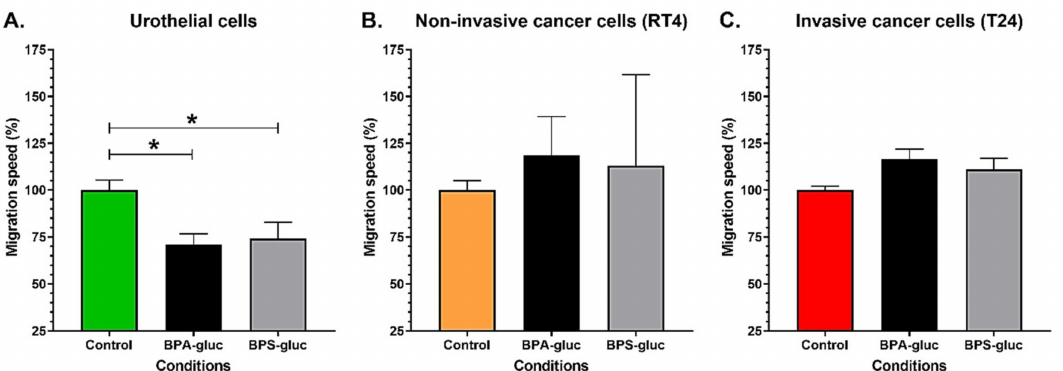
Figure 4. Chronic exposure to physiological concentrations of glucuronidated BPA or BPS decreases the migration speed of normal urothelial cells. The migration speed of ( A ) normal urothelial cells (UCs), ( B ) RT4 non-invasive bladder cancer cells, and ( C ) T24 invasive bladder cancer cells was evaluated by time-lapse microscopy with or without chronic exposure to physiological concentrations of BPA-gluc or BPS-gluc. Data are presented as the mean ± SEM and displayed as percentages of controls (i.e., untreated condition) (n = 2, N = 3). The 100% migration value of UCs’ control represents a mean of 12.1 cm 2 /h, for RT4 1.7 cm 2 /h, and for T24 4.8 cm 2 /h. * p < 0.05 by Mann–Whitney test.